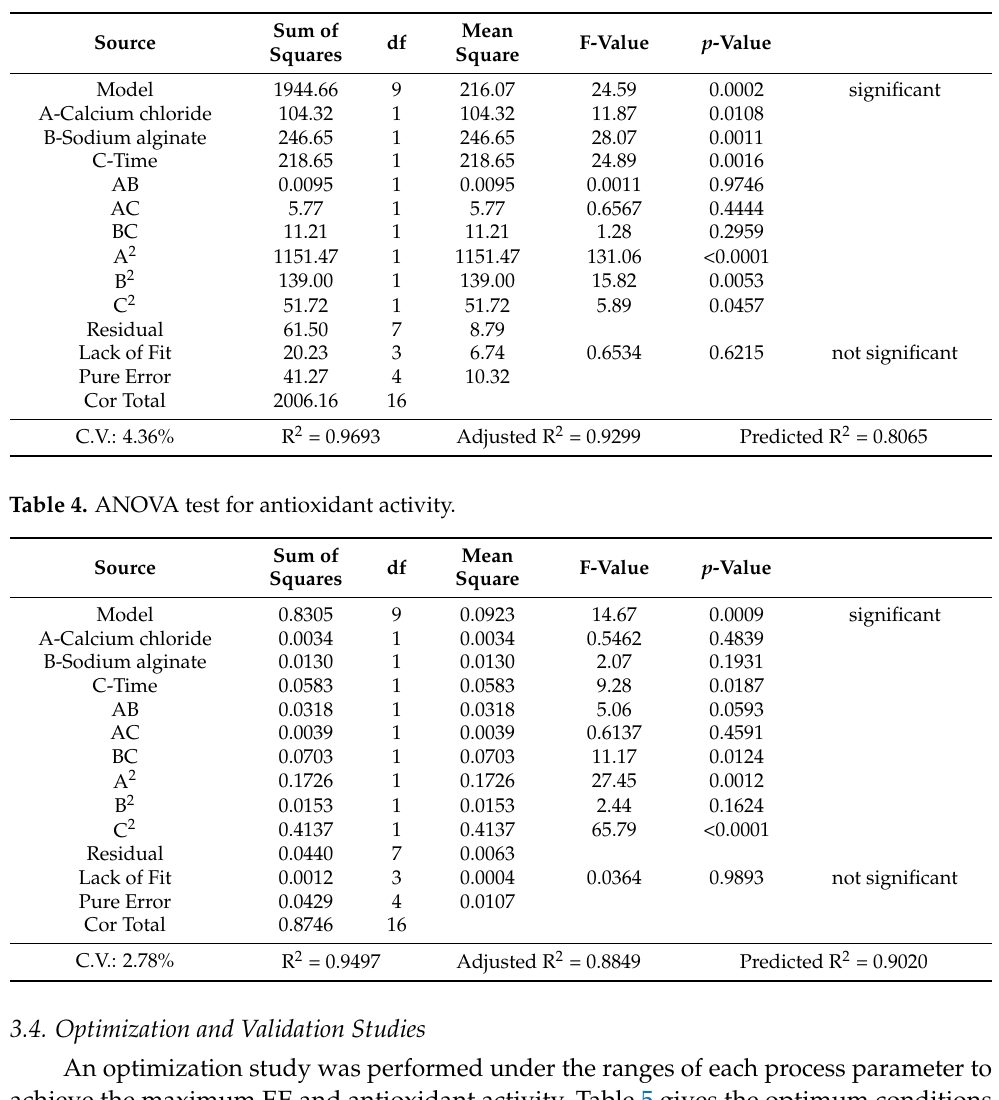
Table 3. ANOVA test for encapsulation efficiency.